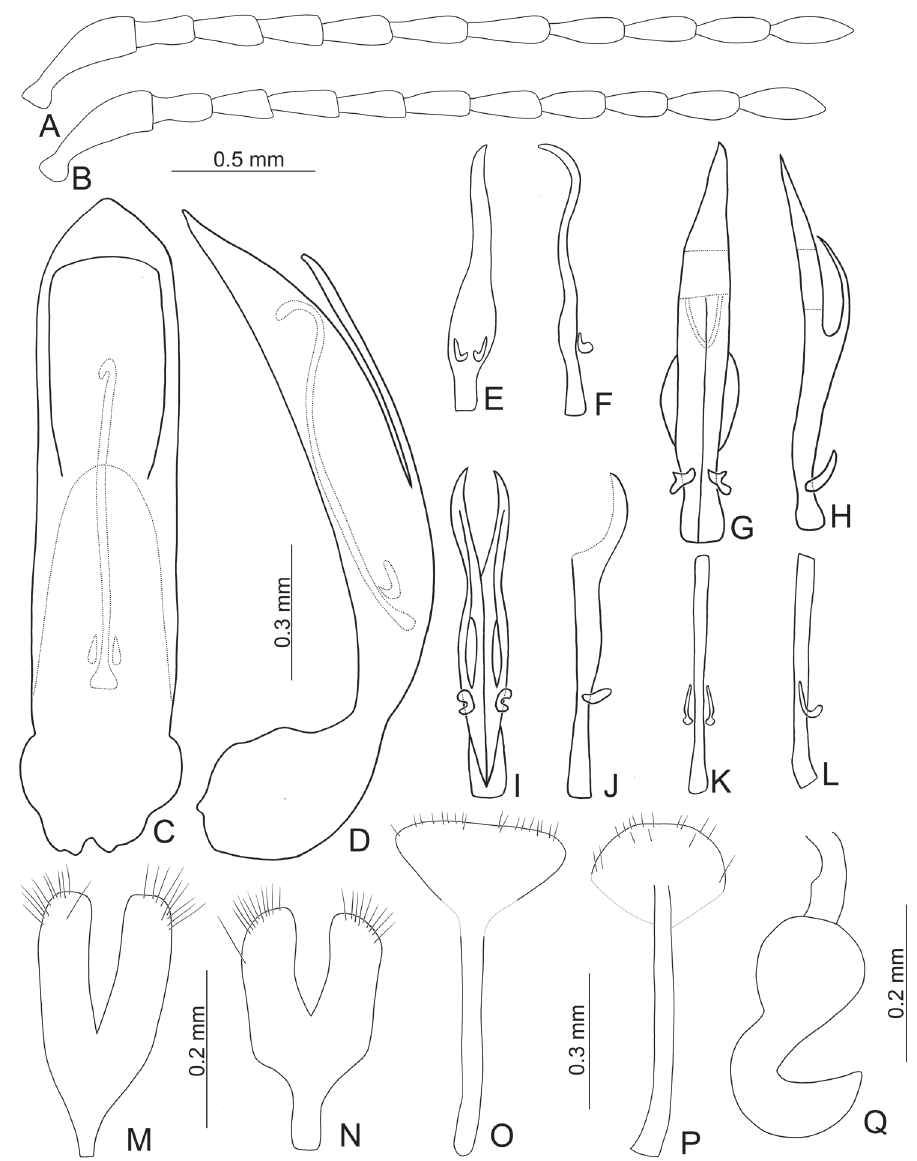
Figure 8. Diagnostic characters of Taiwanoshaira tsoui sp. nov. A antenna, male B antenna, female C pe- nis, dorsal view D penis, lateral view E endophallic sclerites, from Meifeng ( 梅峰 ), dorsal view F ditto, lateral view G same, from Peitungyanshan ( 北東眼山 ), dorsal H ditto, lateral view I samel, from Tah- suehshan ( 大雪山 ), J ditto, laeral view K same, form Taipingshan ( 太平山 ), dorsal L ditto, lateral view M gonocoxae, from Hsiaofengkou ( 小風口 ) N same, from Taipingshan ( 太平山 ) O abdominal ventrite VIII, from Peitungyanshan ( 北東眼山 ) P same, from Taipingshan ( 太平山 ) Q spermatheca. Variation. Specimens from Hsiaofengkou ( 小風口 ) have paler bodies and shorter antenna than others. The endophallic spiculae complexes are variable among